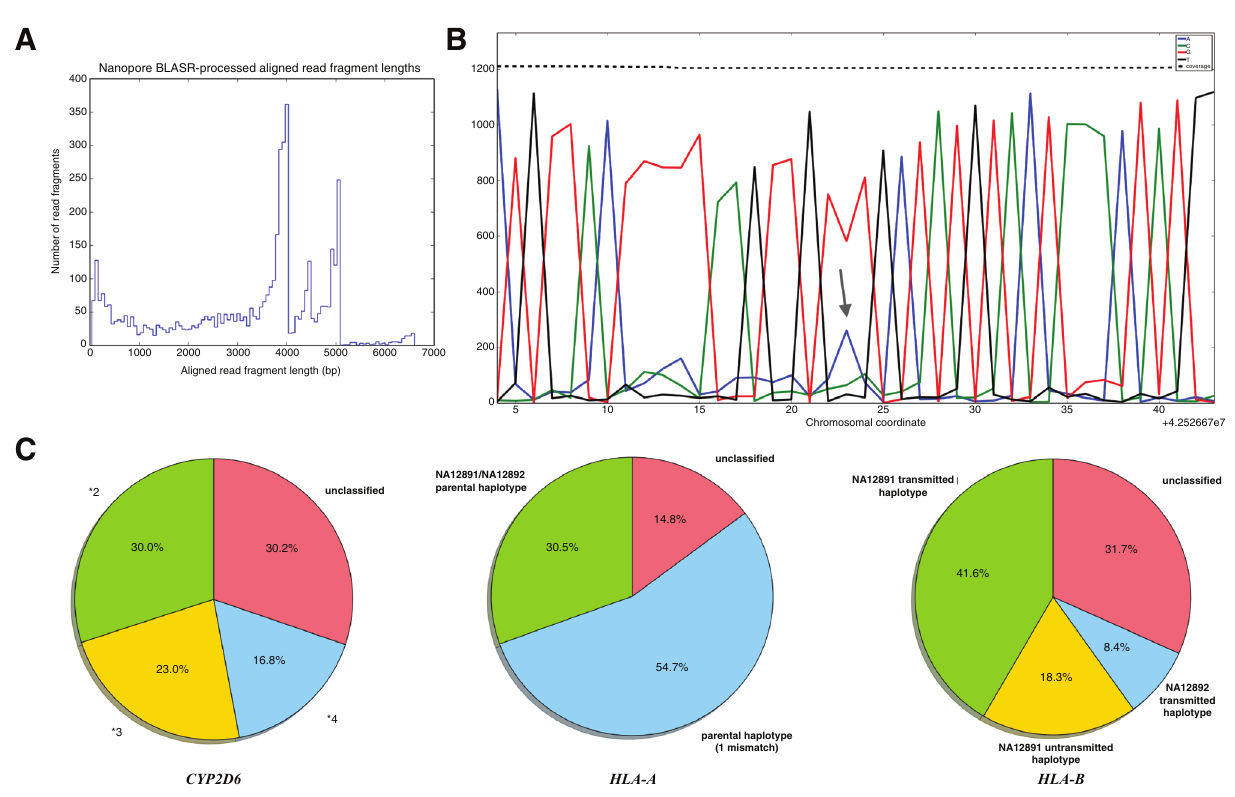
Figure 2. A . Length distribution of aligned reads. 4–5Kb reads represent full-length PCR amplicons. Slightly smaller fragments were likely byproducts of shearing during DNA handling in the experimental protocol. B . With depth of coverage of ~1000× for each of the genes, many chromosomal positions were called with 70–90% consensus. This is a short window of aligned reads for the *4 locus of CYP2D6 with over 1200× coverage. The heterozygous *4 allele rs1065852 is indicated with the arrow. C . Proportions of haplotypes of CYP2D6 , HLA-A and HLA-B when directly measured from individual reads spanning all haplotype